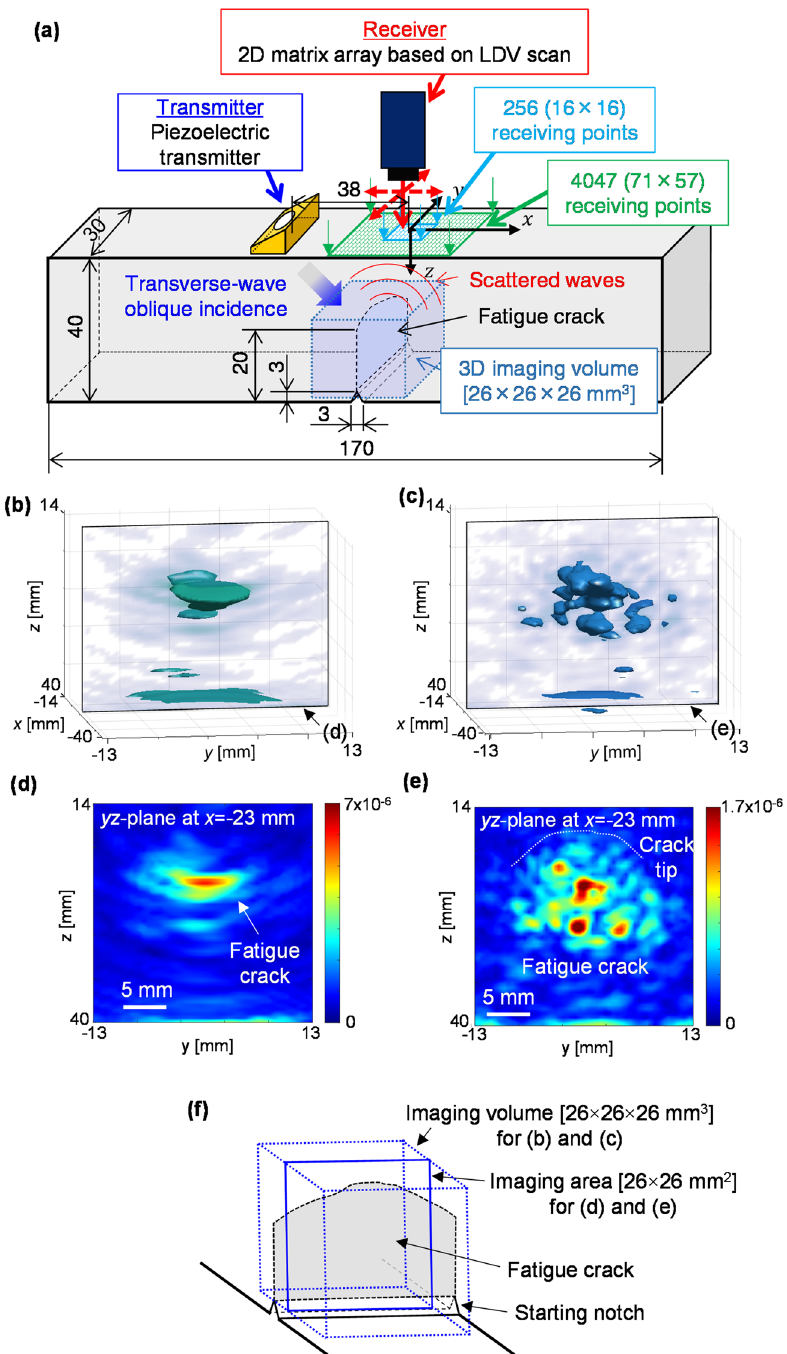
Figure 3. (Color online) Experimental configurations with PLUS with 256 and 4047 receiving points and the imaging results of a fatigue crack. ( a ) Experimental configurations with PLUS with 256 and 4047 receiving points for 3D imaging of the fatigue crack. ( b , c ) 3D images obtained with 256 and 4047 receiving points, respectively. ( d , e ) B-scan ( yz -plane at x = − 23 mm) images extracted from ( b ) and ( c ), respectively. ( f ) Schematic illustrating the relationship between the fatigue crack and the imaging